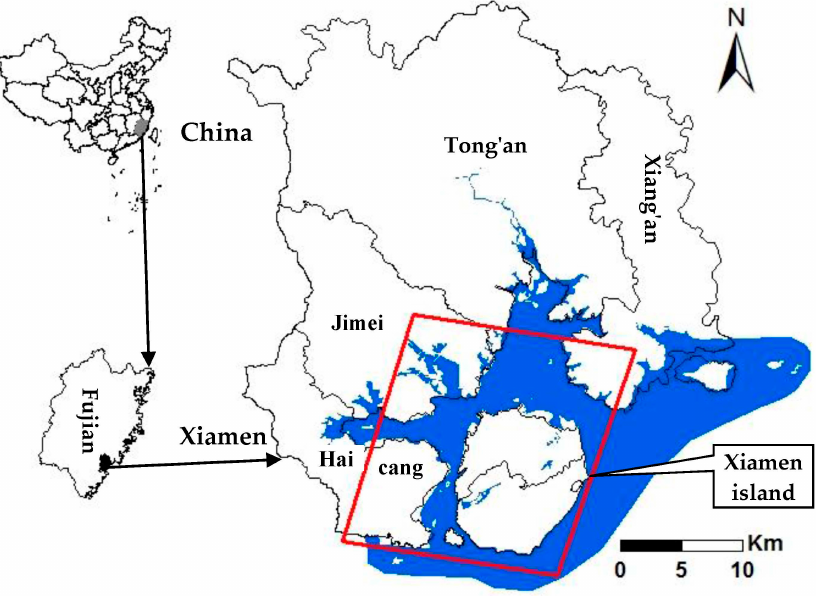
Figure 1. Location of the study area (red box) in 2007; the blue area is the sea.